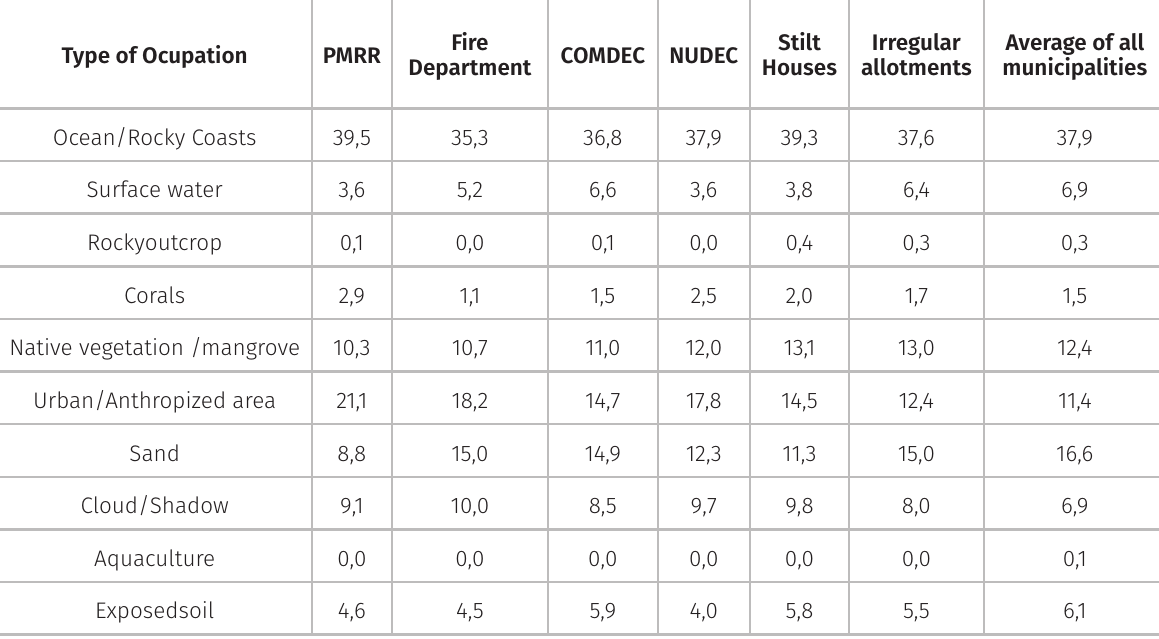
Table I. Crossing of the average occupation by type of municipalities.